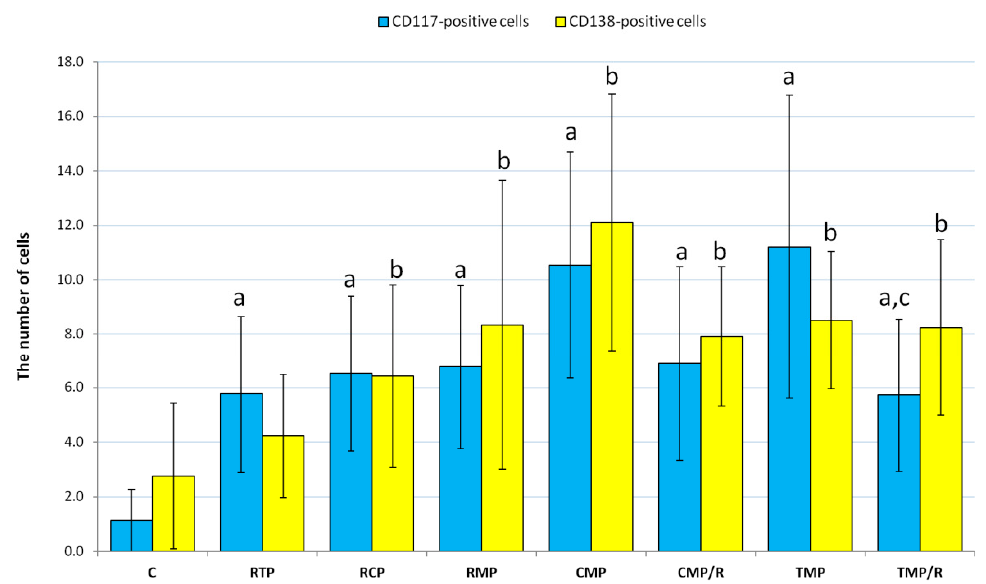
Figure 4. The average number of CD117 + and CD138 + cells in the stroma of rat ventral prostates in